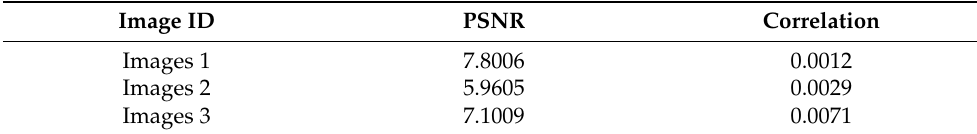
Figure 10. PSNR value = 7.8006, Correlation value = 0.0012. Table 3. PSNR and Correlation